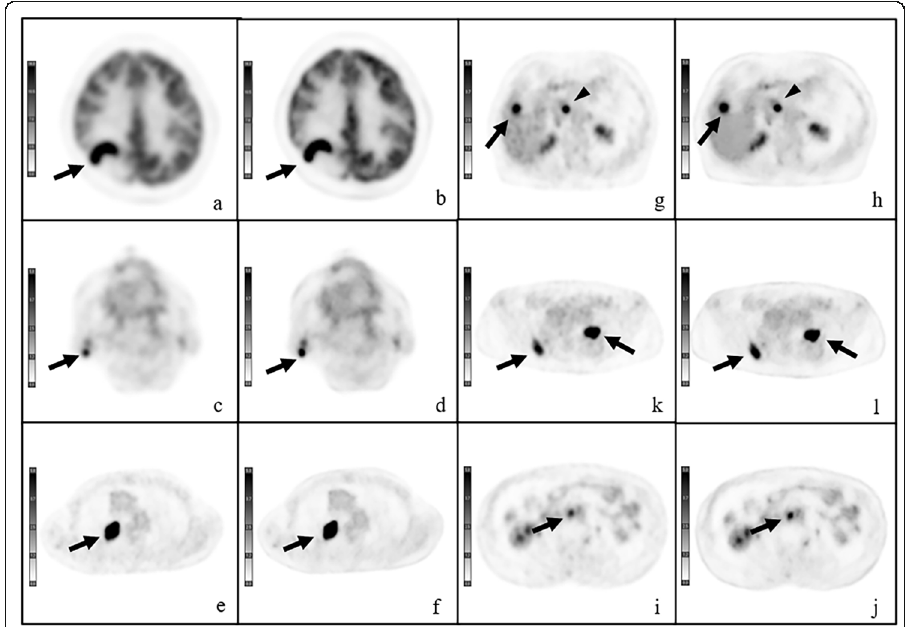
Fig. 5 Representative cases. Axial positron emission tomography (PET) images with conventional Gaussian filter a , c , e , g , i and those obtained with a deep learning method b , d , f , h , l , j . Lymphoma in a 47-year-old woman. Axial PET image shows increased metabolic activity (arrows) in the right parietal lobe a , b . Warthin tumor in an 87-year-old man with lung cancer. Axial PET image shows increased metabolic activity (arrows) in the right parotid gland c , d . Recurrent tumor in a 77-year-old man after surgery for lung cancer. Axial PET image shows increased metabolic activity (arrow) in the right lung e , f . Liver and lymph node metastases in an 88-year-old woman after surgery for lung cancer. Axial PET image shows increased metabolic activity in the right lobe of the liver (arrows) and paraaortic lymph nodes (arrowheads) g , h . Lymph node metastases in a 70-year-old man after surgery for colon cancer. Axial PET image shows increased metabolic activity (arrow) in the right paraaortic lymph node i ,